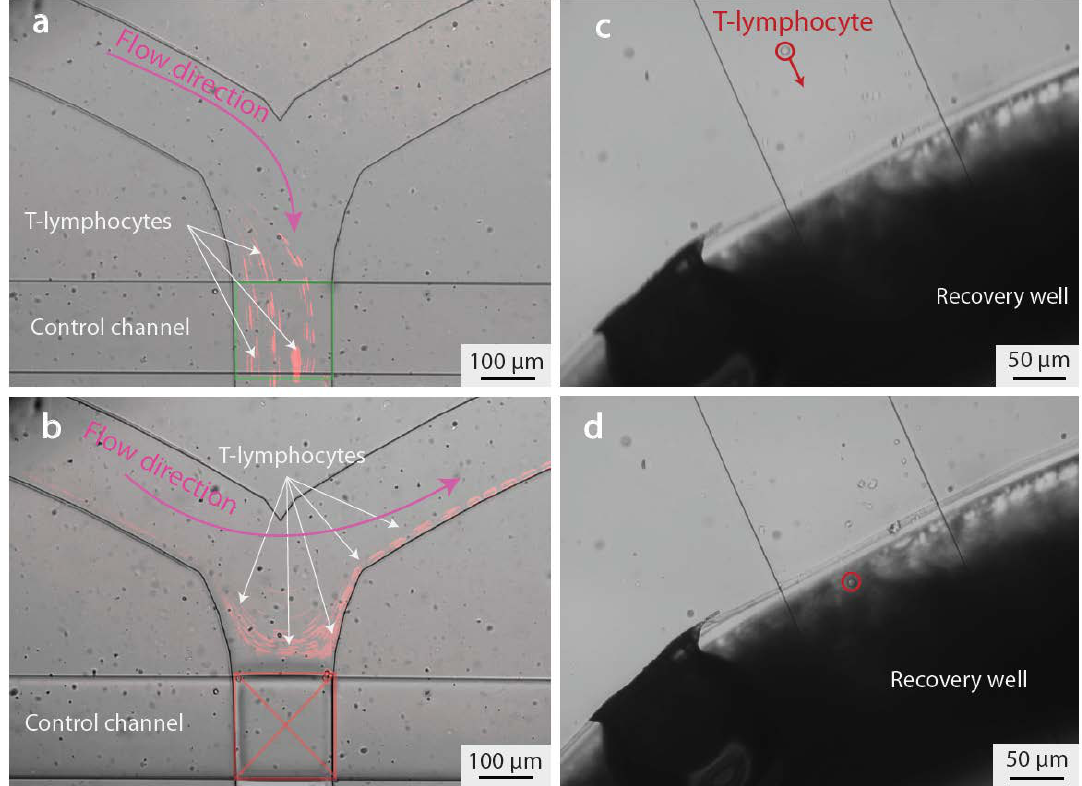
Figure 4. Single-cell recovery. ( a,b ) Operation of a hybrid SU-8/PDMS valve used to control the flow